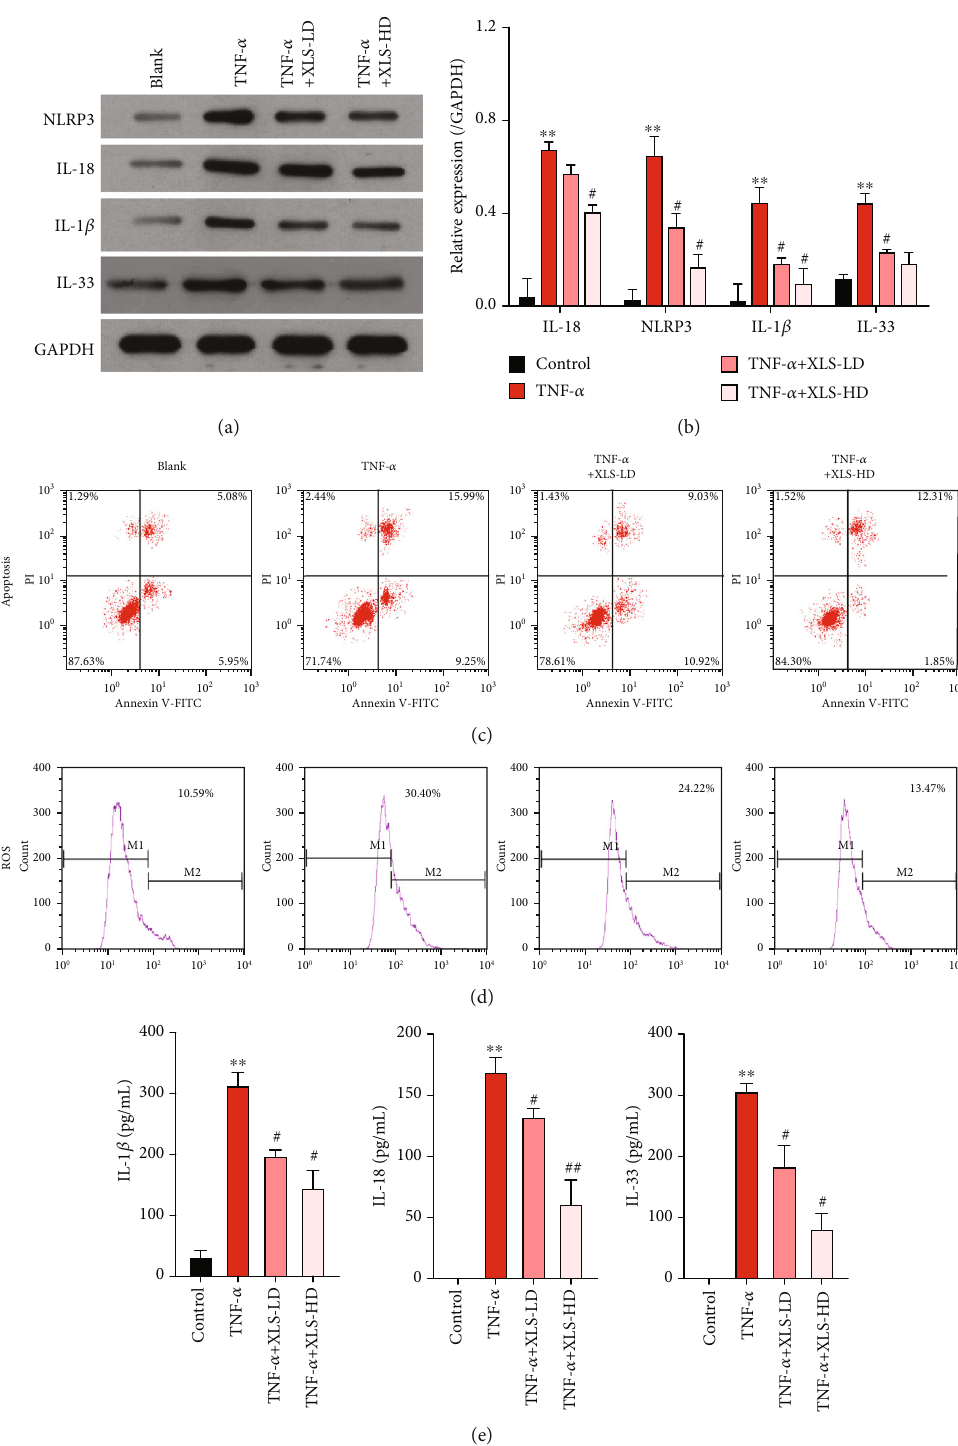
Figure 4: Xi Lei San inhibited NLRP3 in fl ammasome activity and apoptosis and reduced the levels of ROS and in fl ammatory cytokines in TNF- α -stimulated CACO2 cells. A cellular model of colitis was constructed by inducing CACO2 cells with TNF- α , and groups of colitis model cells were then treated with low or high doses of Xi Lei San, respectively. (a) NLRP3, IL-18, IL-33, and IL-1 β levels in the CACO2 cells were examined by western blotting. (b) A statistical analysis of western blotting results was performed based on grayscales. (c) The e ff ect of Xi Lei San on the apoptosis of TNF- α -induced CACO2 cells was examined by fl ow cytometry. (d) The ROS levels in each group of CACO2 cells were also examined by fl ow cytometry. (e) ELISA was performed to monitor IL-1 β , IL-18, and IL-33 levels. ∗∗ P < 0 : 01 vs. the control group; # P < 0 : 05 and ## P < 0 : 01 vs. the TNF- α